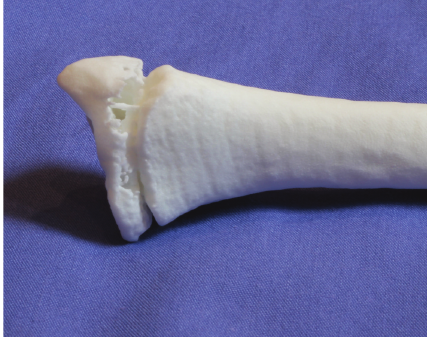
Figure 10: Distal radius showing level of physeal